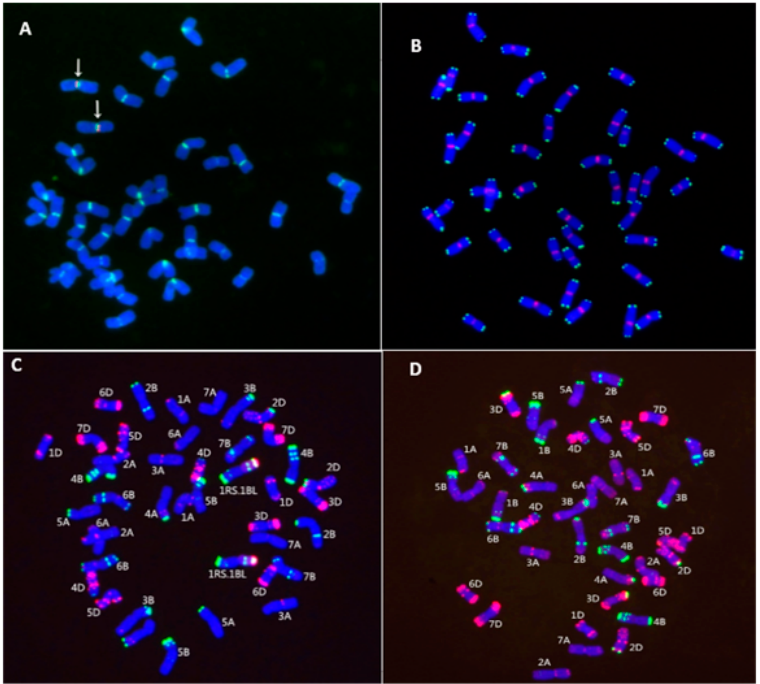
Figure 1. Chromosome identification of RT843-5 by MC-FISH. ( A ): Signal patterns of pMD-CEN-3 (a rye-specific centromeric probe, red) and 6c6 (a wheat-specific centromeric probe, green) joined together in the centromere region. The arrows indicate the translocation chromosomes. ( B ): 6c6: red, (5 ′ -CCCTAAA-3 ′ ) 4 (a telomere-specific probe): green. ( C ): Chromosome constitution of the novel T1RS.1BL translocation line RT843-5 (2 n = 42). ( D ): Chromosome structure of MY11. No rye chromatin was detected.